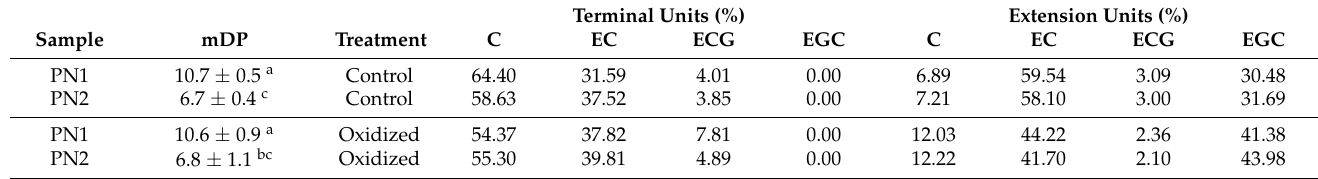
Table 5. The summarized table of mean degree of polymerization (mDP) and percentage of monomers in the breakdown of the phenolic in polymer fractions in the Pinot noir wine lees. Terminal Units (%) Extension Units (%)